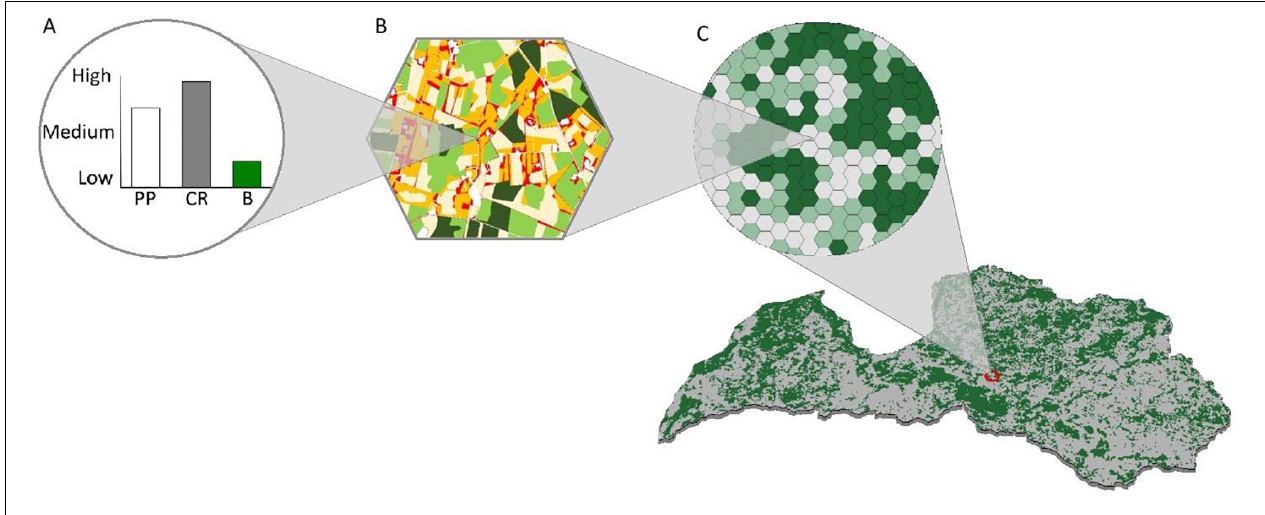
FIGURE 4 | Hierarchy of data calculation and visualization levels: (A) evaluation of supply— (B) polygon (calculation)— (C) hexagon